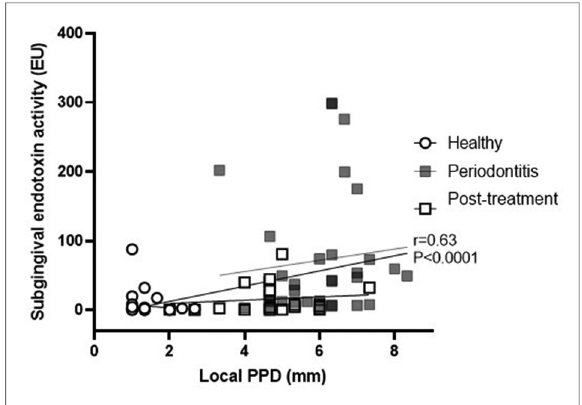
FIGURE 1 Association between subgingival endotoxin activity and the local probing pocket depth.